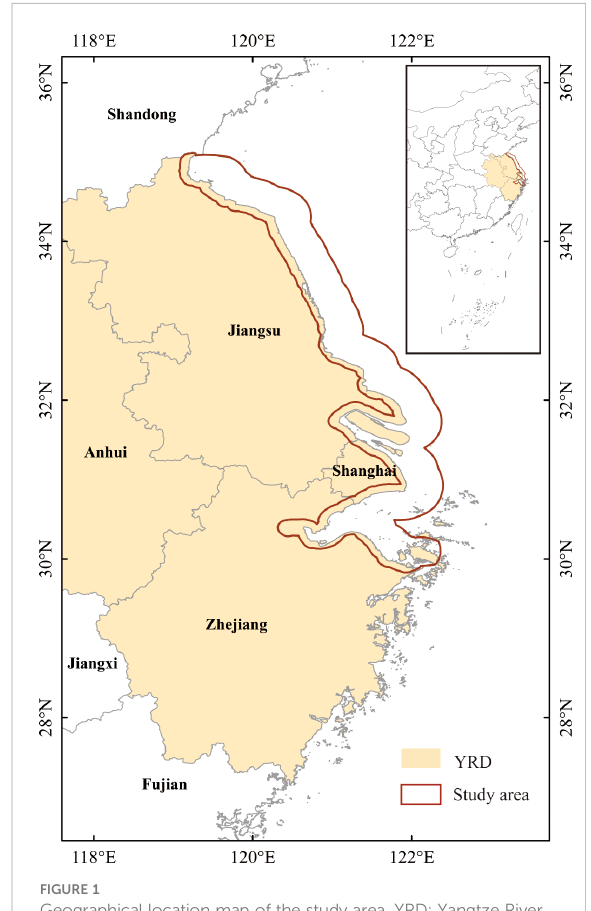
FIGURE 1 Geographical location map of the study area. YRD: Yangtze River Delta, including Shanghai, Jiangsu, Zhejiang, and Anhui